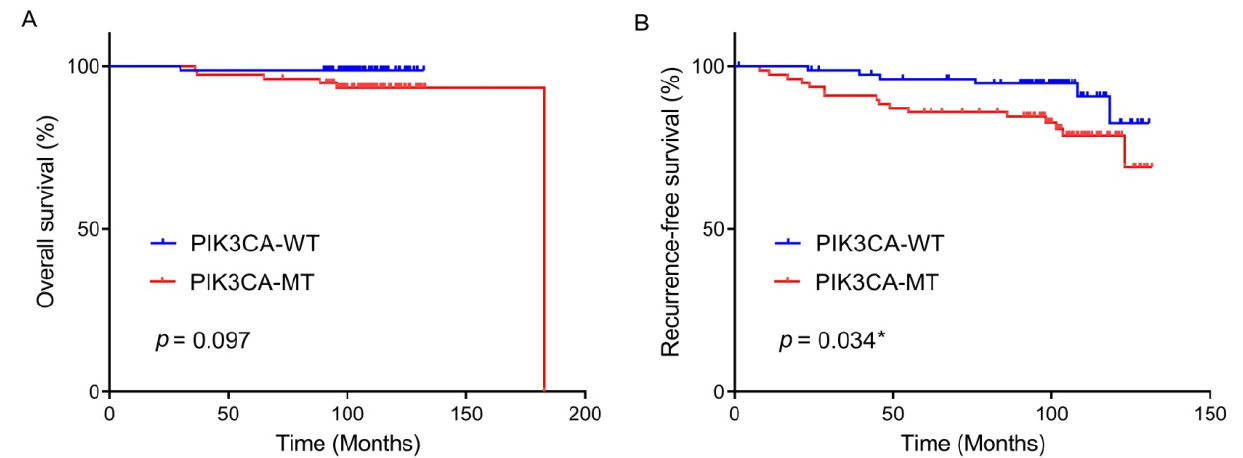
Figure 2. Overall survival rate ( A ) and recurrence-free survival rate ( B ) by PIK3CA mutational status in the patients with breast cancer who underwent curative surgery and adjuvant chemotherapy. * statistically significant, p value < 0.05. To explore prognostic factors for OS and RFS in patients with BCs, univariate and multivariate Cox proportional hazard regression methods were analyzed (Table 2), which also supported the relevance of PIK3CA mutation with worse RFS, but not with OS. The univariate analysis revealed no PD-L1, c-Met expression, or MSI/dMMR influence on OS or RFS, although the trend toward a poor RFS in c-Met expressed tumors showed borderline statistical significance ( p = 0.052). Lymphovascular invasion significantly affected OS ( p = 0.011). From the multivariate analysis, PIK3CA mutation was proved to be an independent poor prognostic factor related to RFS (hazard ratio 3.543, 95% CI 1.047–11.988, p = 0.042). Table 2. Univariate and multivariate analyses of overall survival and recurrence-free survival of patients with breast